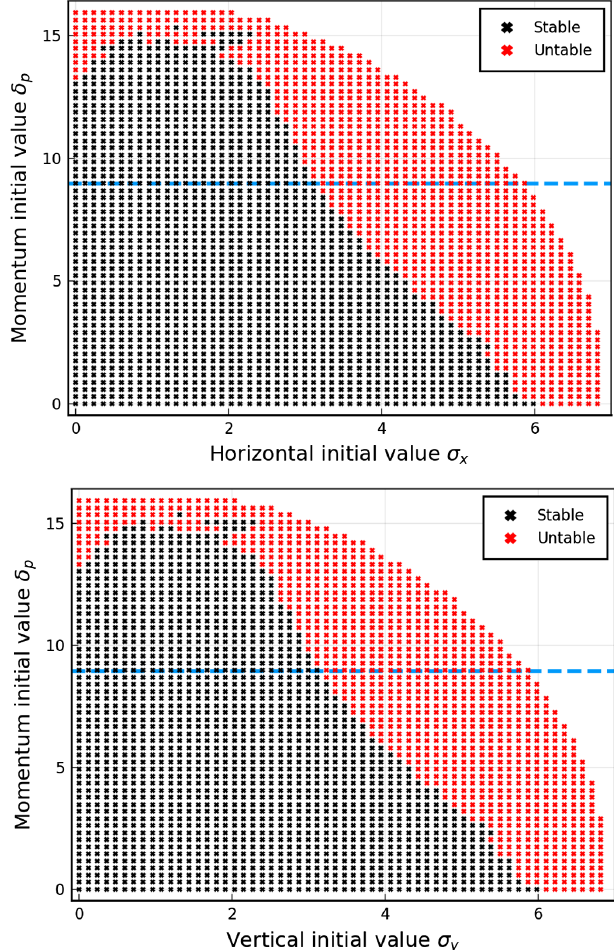
FIG. 6. Dynamic aperture tracking result by ELEGANT (black: survived particles; red: lost particles). The dashed line is the rf- 21 nm, ϵ 18 nm, δ momentum aperture ( ϵ x; y; rms ¼ p; rms ¼ rms ¼ 8 . 9 × 10 − 4